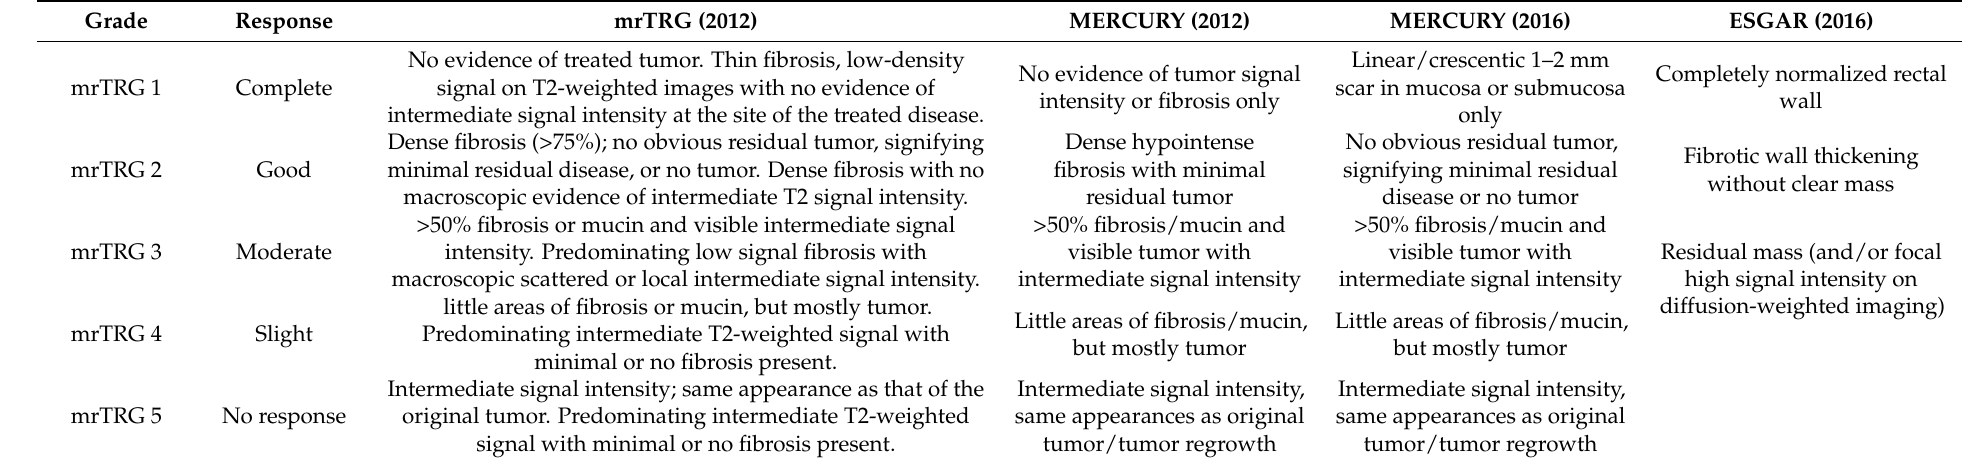
Table 3. Evaluation systems of rectal cancer response in post-NAT